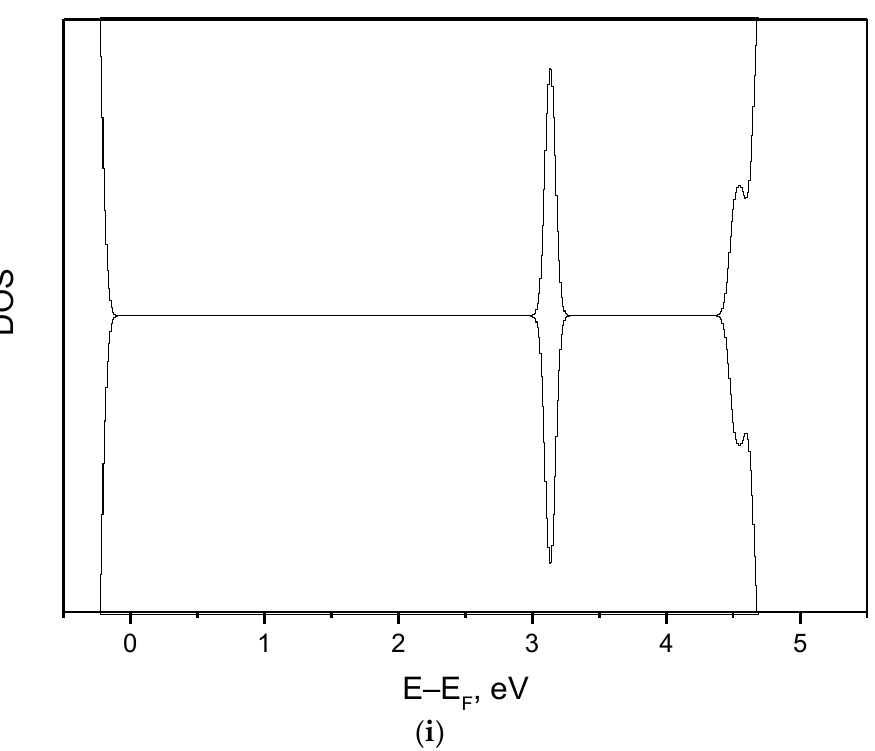
Figure 3. Density of states (DOS) for various combinations of F-type centres, as described in Table 4 and shown in Figure 1. ( a ) 0. ( b ) 0.25. ( c ) 0.5. ( d ) 0.75. ( e ) 1. ( f ) 1.25. ( g ) 1.5. ( h ) 1.75. ( i ) 2.